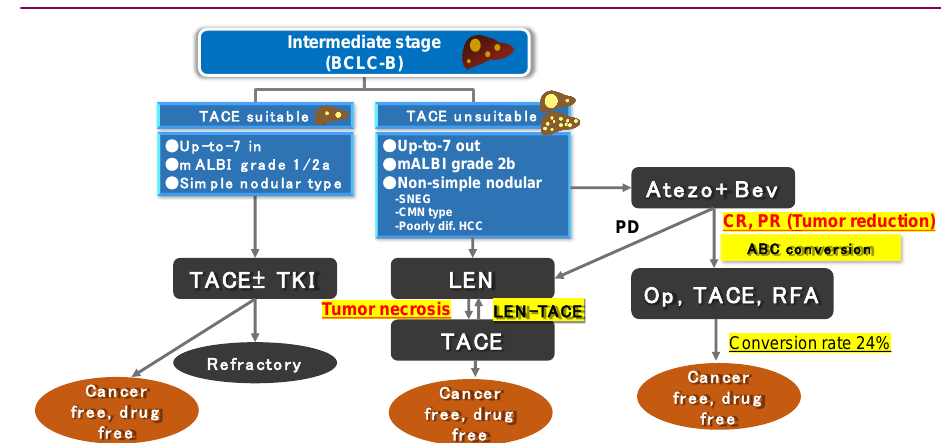
Figure 5. Treatment strategy of intermediate-stage hepatocellular carcinoma. Response of LEN– TACE sequential therapy strongly depends on tumor hypoxic/necrotic change, including with lenvatinib. On the other hand, curative conversion in ABC conversion strongly depends on the tumor shrinkage/reduction effect from atezolizumab plus bevacizumab combination therapy. mALBI grade, modified albumin-bilirubin grade; TACE, transarterial chemoembolization; TKI, tyrosine kinase inhibitor; SNEG, simple nodular type with extra growth; CMN type, confluent multinodular type; ABC conversion, atezolizumab plus bevacizumab followed by curative conversion; LEN, lenvatinib.